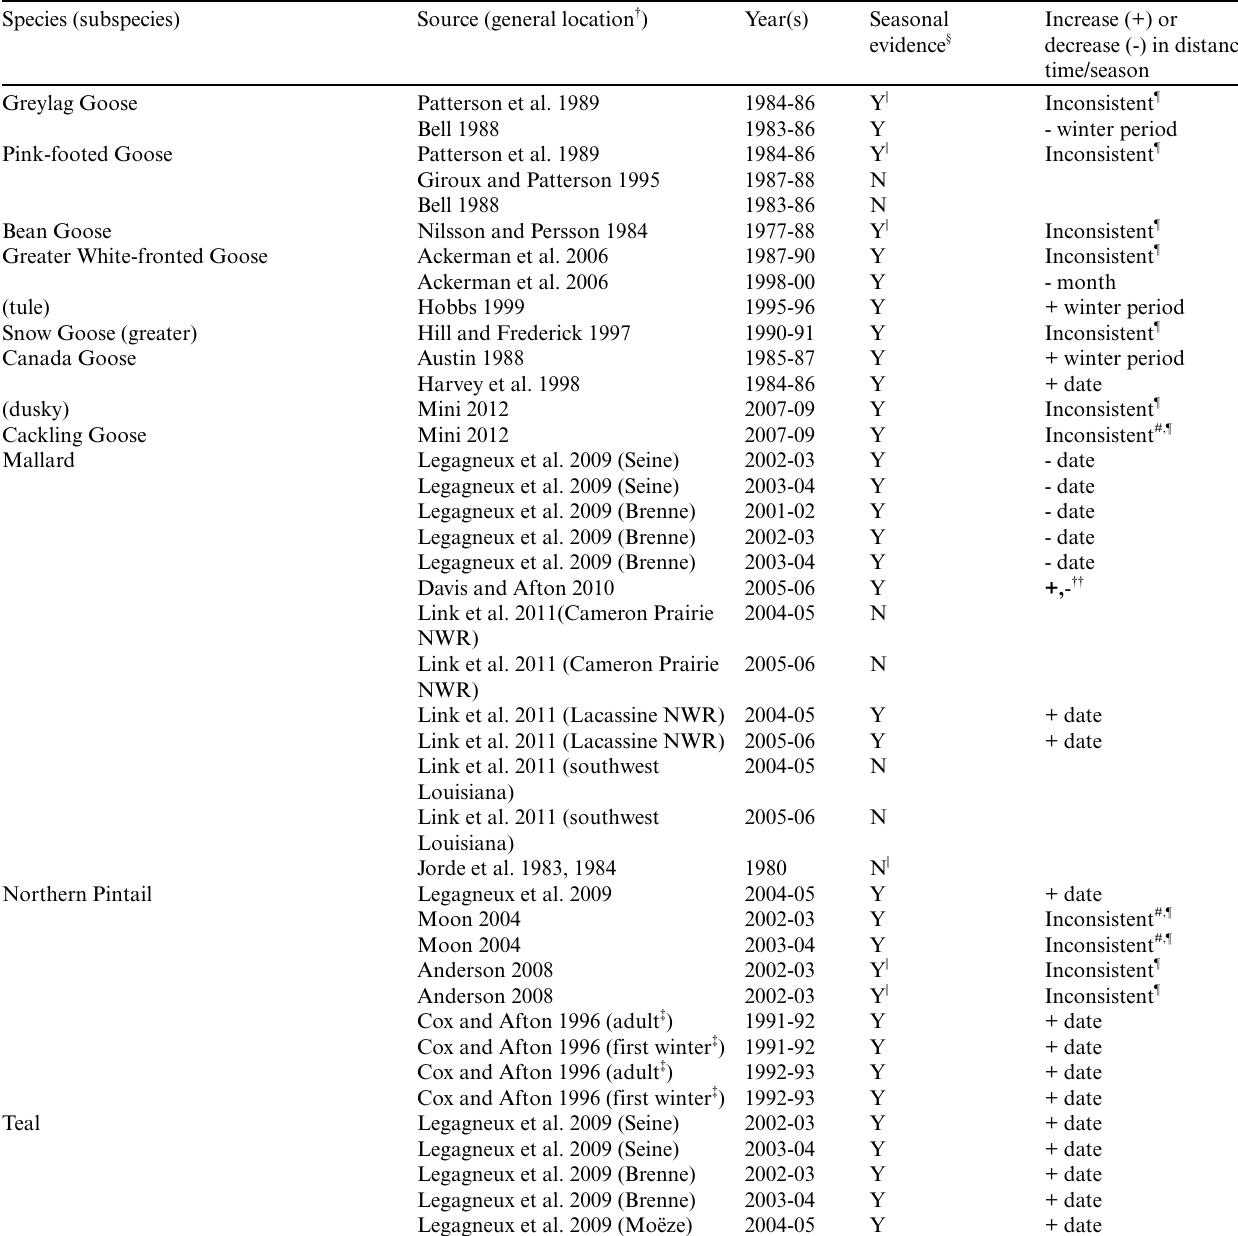
Table 2 . Studies supporting temporal effects, either through statistical evaluation or qualitative presentation of data, in distance waterfowl fly from roost sites to forage. Scientific names for all species listed in Appendix